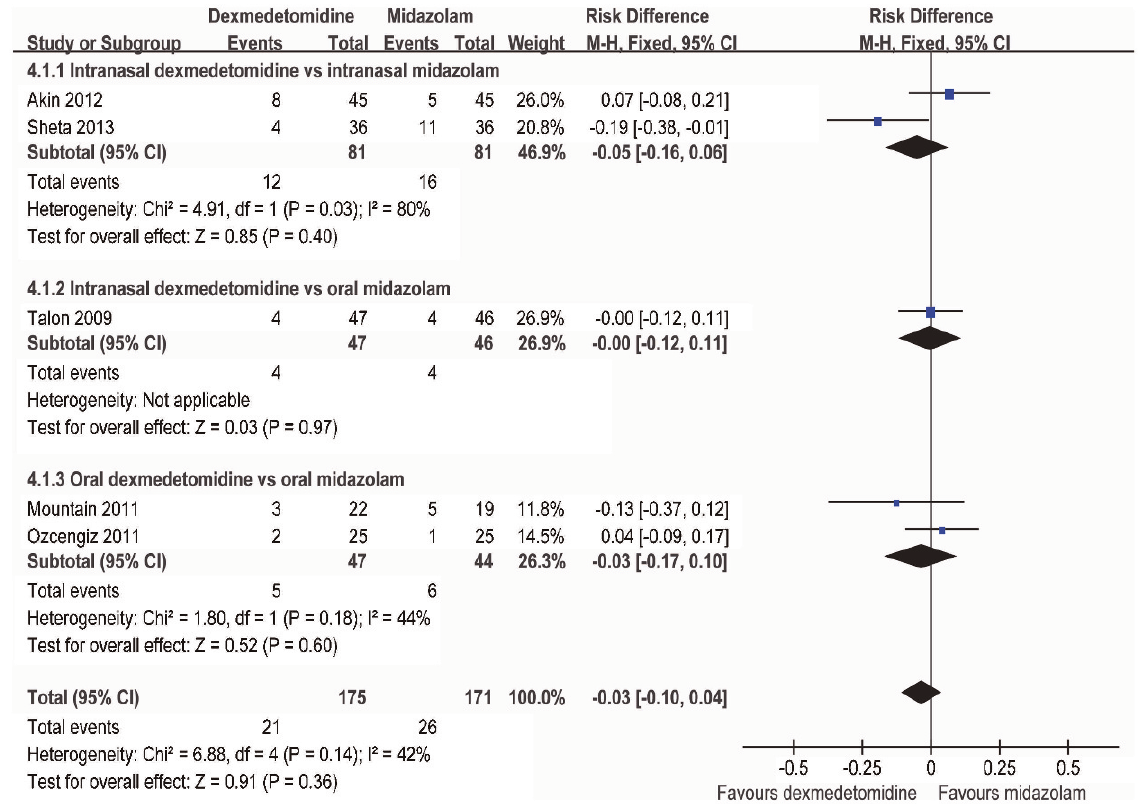
Figure 5 - Meta-analysis of EA in children treated with dexmedetomidine vs . midazolam. EA: emergence agitation.